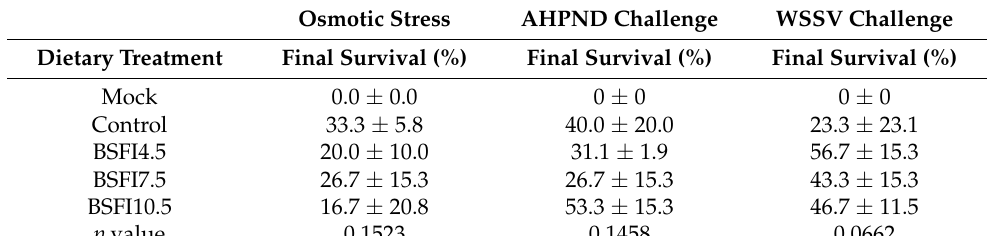
Figure 1. Nevertheless, a pattern of high survival for the BSFI-fed shrimp compared to the control treatment was recorded during the WSSV challenge trial (Table 3).